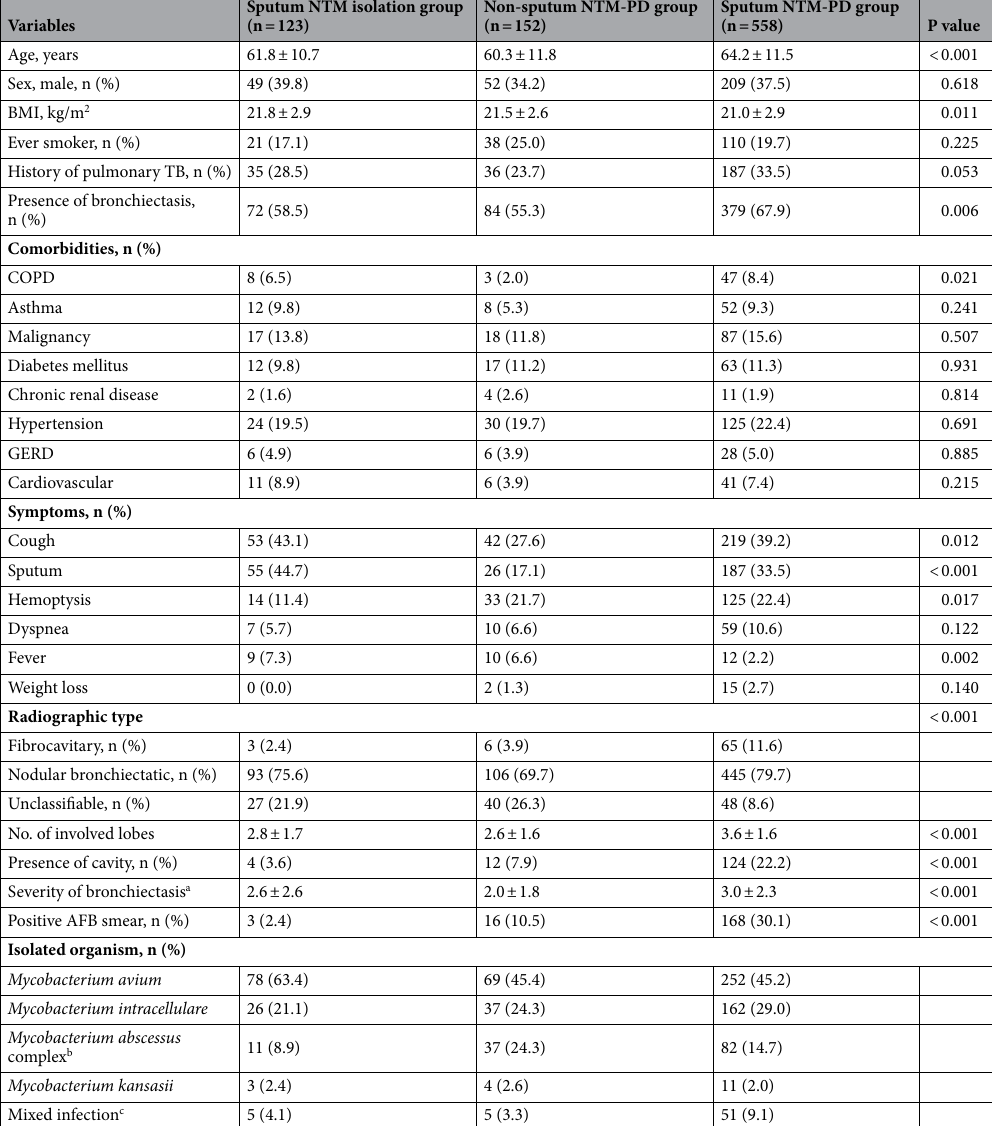
Table 1. Baseline characteristics and clinical features of the patients. Categorical variables are expressed as number (%); continuous variables are expressed as mean ± standard deviation. AFB acid-fast bacillus, BMI body mass index, COPD chronic obstructive pulmonary disease, GERD gastroesophageal reflux disease, NTM nontuberculous mycobacteria, NTM-PD nontuberculous mycobacterial pulmonary disease,